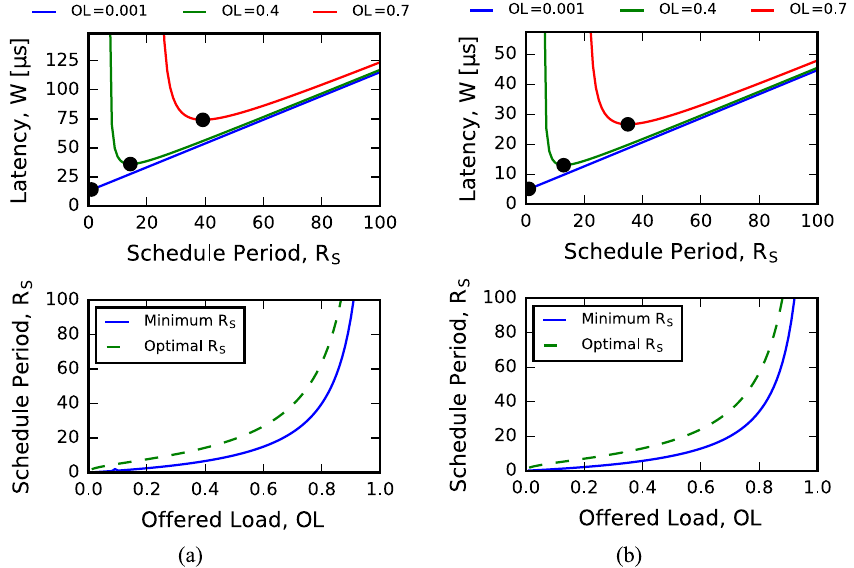
Figure 16. Latency prediction (top) and optimization (bottom) plots for two applications. In the latency plots, the optimal R S for minimum latency is indicated by a dot. ( a ) COS with C = 10, N = 10 C , S = 100 ( b ) AES with C = 14, N = 8 C , S =